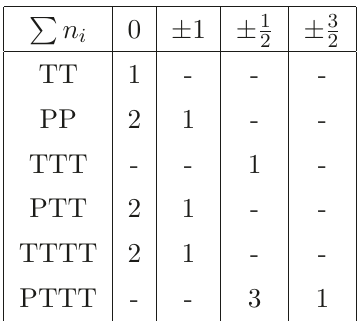
Table 1 . Counting projective P 0 representations in tensor